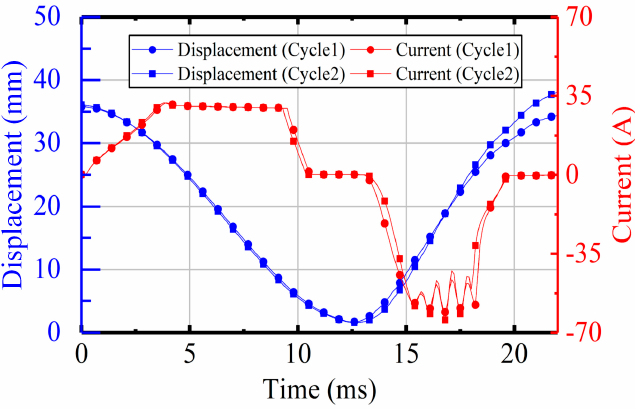
Figure 24. The tested piston motion controlled by peak pressure.